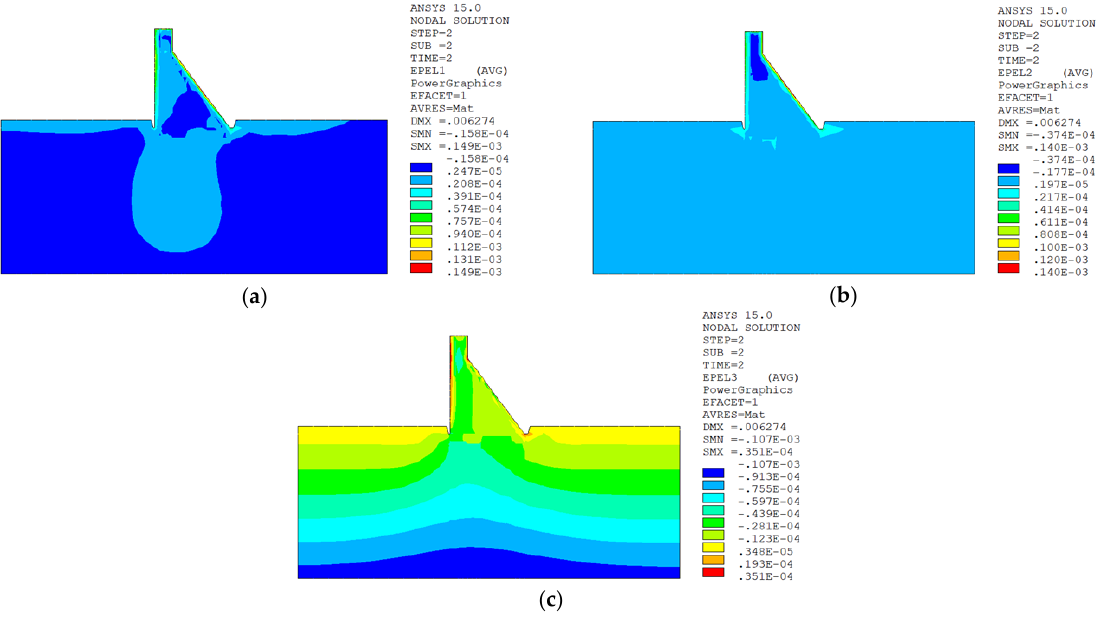
strain, ( b ) The cloud chart of the second principal strain, ( c ) The cloud chart of the third principal strain.